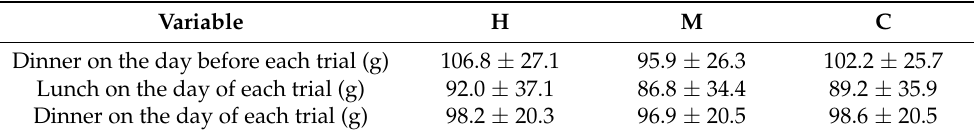
Table 3. Carbohydrate